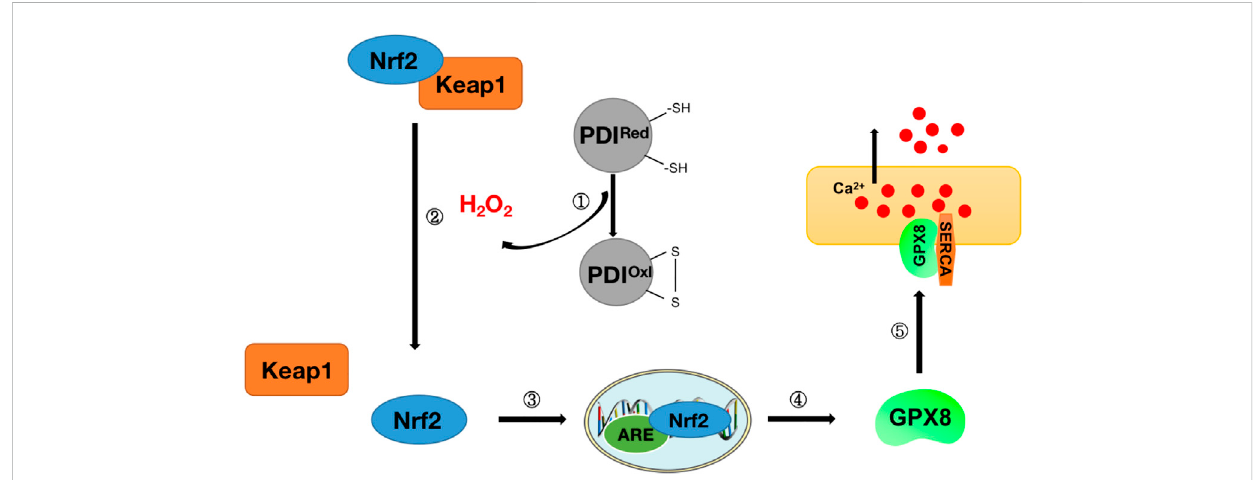
FIGURE 7 Diagram of protein oxidative folding-Nrf2-ER calcium axis mechanism. Step ① : Release of H 2 O 2 during protein oxidative folding (see Figure 6 for details of protein oxidative folding); Step ② : Nrf2 and Keap1 complexes dissociate under H 2 O 2 stimulation to release Nrf2; Steps ③ - ④ : Nrf2 enters the nucleus and binds to antioxidant response elements (ARE) to stimulate therelease of downstream antioxidant GPX8; Step ⑤ : GPX8 interacts with SERCA to regulate Ca 2+ in the endoplasmic